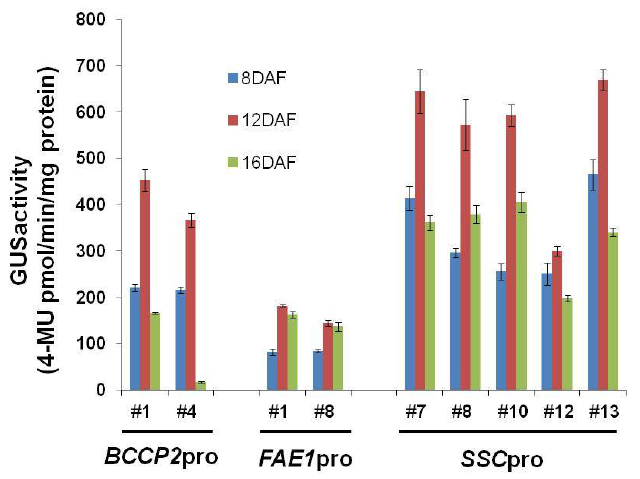
Figure 2. β-glucuronidase ( GUS ) activity in seeds at 8, 12 and 16 days after flowering (DAF). Quantitative analysis of β-glucuronidase ( GUS ) activity in seeds at 8, 12 and 16 days after flowering (DAF) from transgenic plants containing the biotin carboxyl carrier protein 2 ( BCCP2 ), fatty acid elongase 1 ( FAE1 ) and the seed-specific chimeric ( SSC ) promoters. Values represent means of three independent experiments. Statistical analysis carried out by Student’s t -test. Error bars represent standard deviation.